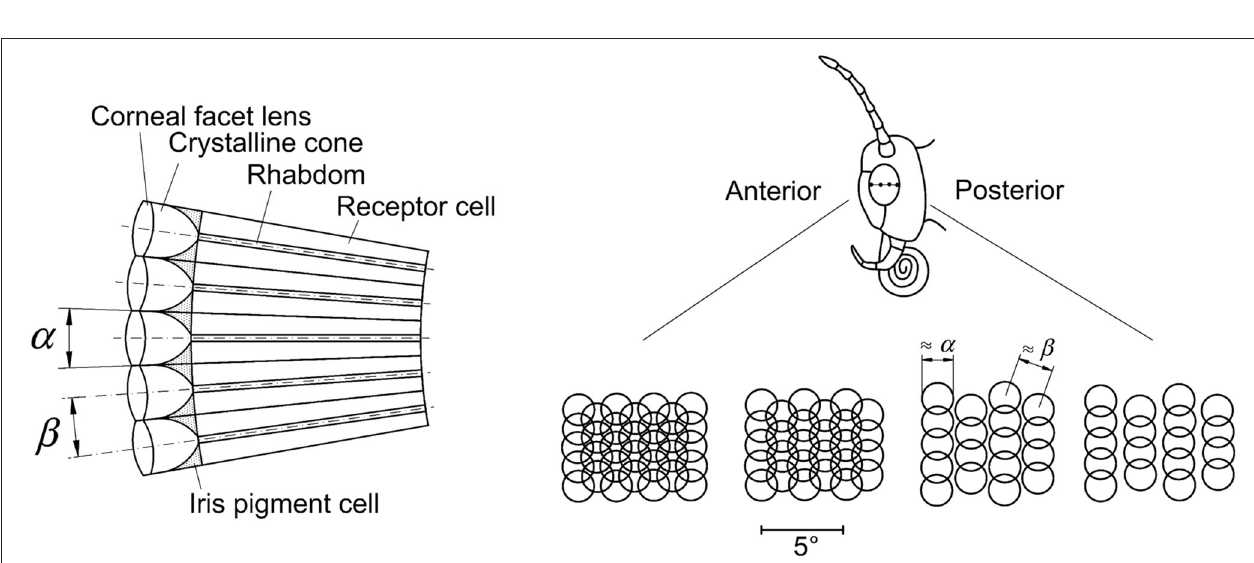
FIGURE 3 | Left: Five ommatidia are shown schematically, each with a lens, a crystalline cone, a rhabdom and receptor cells. The receptor cells are synaptically connected to neurons (not shown). The angle α is the acceptance angle of a single ommatidium, and the angle β is the angle between the axes of two neighboring ommatidia, referred to as the inter-ommatidial, or inter-receptor angle. Right: The top picture shows a butterfly head from the left side with the eye in the middle. Indicated are the positions from where the receptive fields are shown in the bottom row. In most flying insects, the ommatidial receptive fields are not always separated, but may overlap (Land and Nilsson, 2012). Going from anterior to posterior they change in the depicted case from overlapping “horizontally” and “vertically” to overlapping only “vertically.” The angle α from left corresponds to the diameters of the circles representing the ommatidial receptive fields, and the angle β corresponds to the distance between the centers of neighboring circles. Smaller angles β in the front of the head (anterior), i.e., overlapping circles, and larger ones laterally (more posterior) are apparently advantageous in fast forward flight.